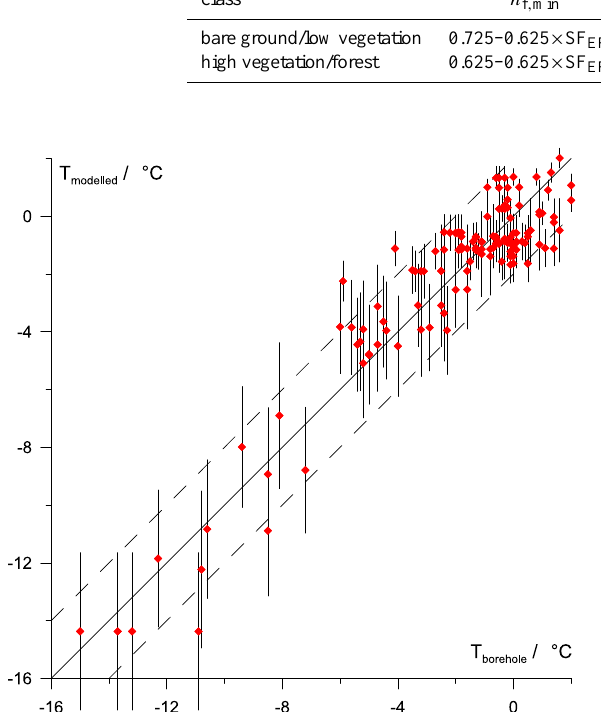
Figure 2. Measured vs. modeled ground temperatures for 143 bore- hole sites (International Permafrost Association, 2010). The error bars represent one SD of all model realizations, the dashed lines are the ± 2 ◦ C intervals around the 1 : 1 line (in solid).